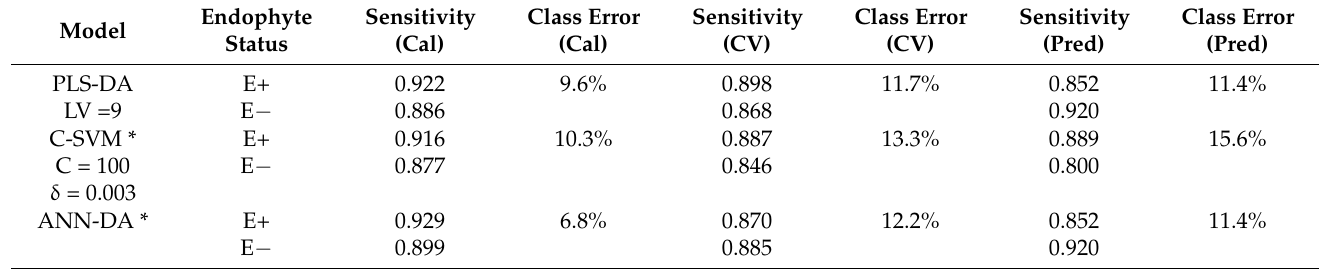
Table 4. Classification models using 75 optimal wavelengths for E+ ( n = 550) and E − ( n = 455) calibration dataset and E+ ( n = 27) and E − ( n = 25) prediction dataset.